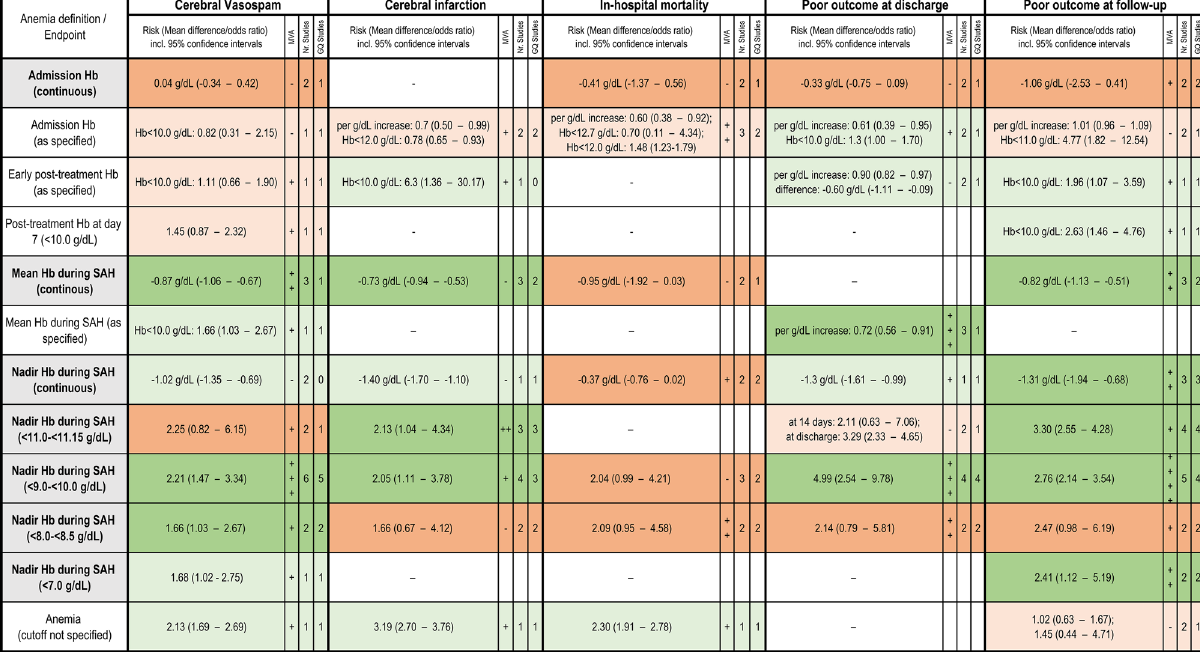
Figure 3. Summary overview of the evidence for the association between anemia severity and primary endpoints. The risk for each primary endpoint is reported for continuous and dichotomous Hb values. Correlations tested in multivariate analysis, the number of studies included per subgroup and the number of good-quality studies are reported. Significant associations reaching the evidence level I-II are marked dark green, the associations with lower evidence—light green. Non-significant findings are marked orange or light orange for associations with an evidence level I–II or lower, respectively. Hb Hemoglobin, SAH subarachnoid hemorrhage, GQ good quality, MVA multivariate